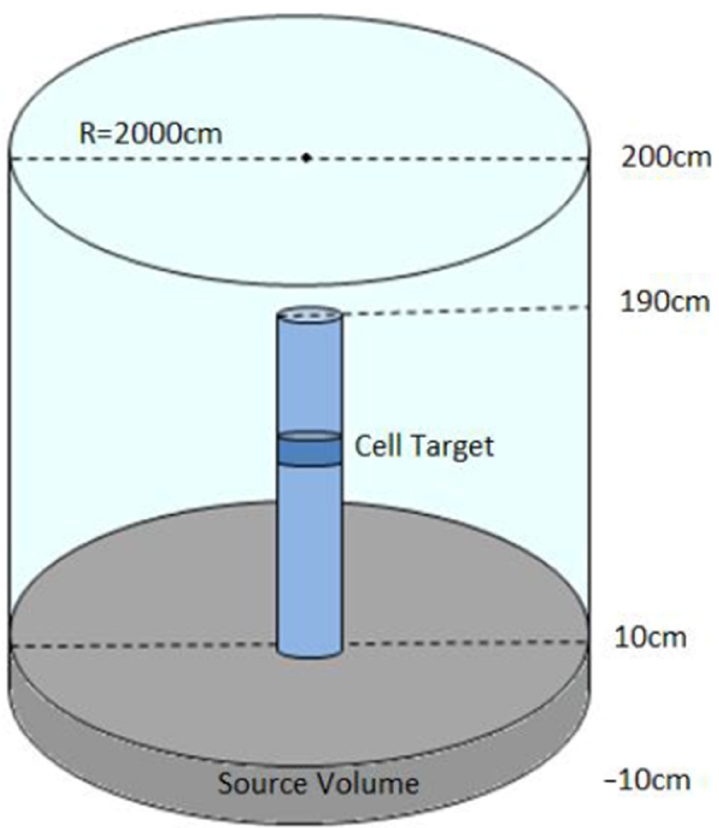
Figure 1. MC geometry model of the MCNP6.1 simulation including the source, the phantom and all the patterns used in it. The whole setting is as follows: the human phantom (depicted as a blue thin cylinder of 1.80 m height and 25 cm radius) stands in the middle of the outer azure cylinder (radius 20 m) which is filled with air (surrounding environment). The grey base cylinder (radius 20 m) represents the source volume on which the “human” stands (i.e., the surrounding ground, composed of soil and contaminated with the radionuclide 137 Cs in different surface activity values). There is no proportionality in the depicted dimensions of the patterns for the sake of